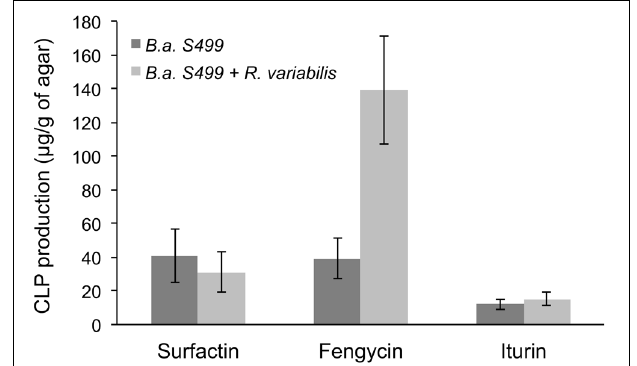
FIGURE 4 | Determination of lipopeptides accumulating in the inhibition zone upon confrontation of strain S499 with R. variabilis . Production of surfactin, fengycin, and iturin by B. amyloliquefaciens S499 evaluated by UPLC–MS in presence (light gray) or absence (dark gray) of R. variabilis . Microorganisms were grown together for 4 days at 25 ◦ C. Data are means and SD calculated from the analyses of four extracts prepared from independent plates.